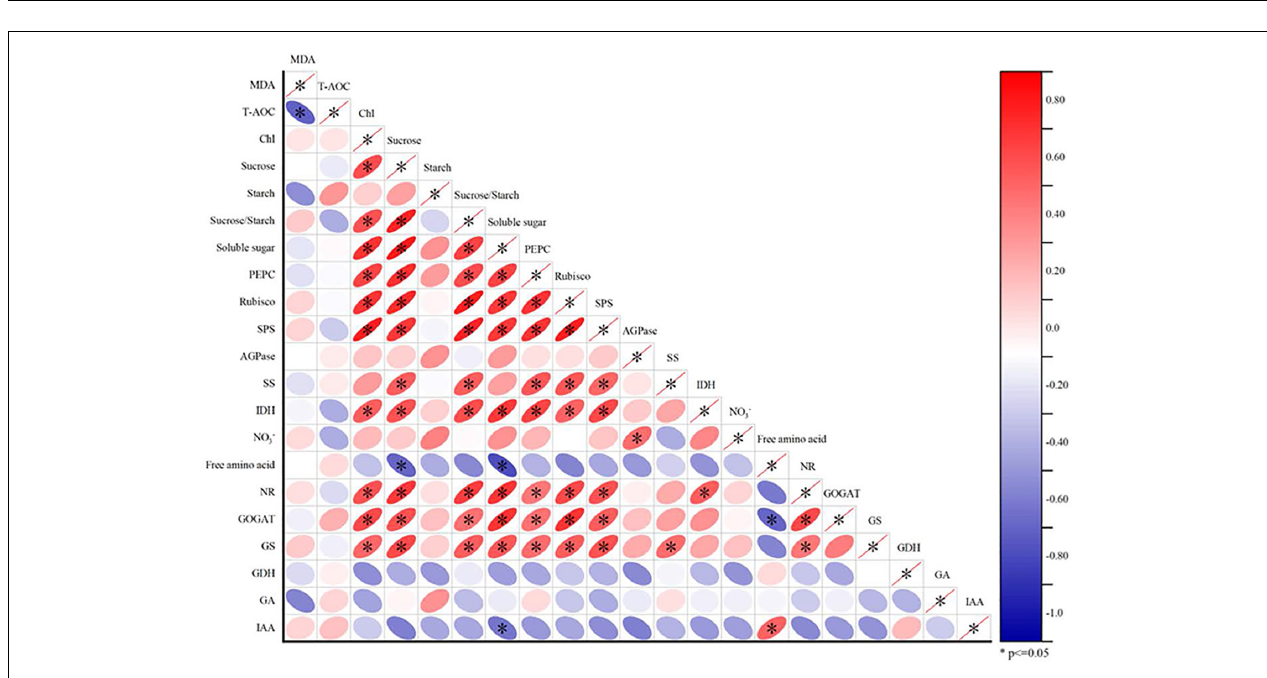
FIGURE 4 | Correlation analysis of maize leaf oxidative stress (MDA, T-AOC), carbon assimilation (Chl, sucrose, starch, sucrose/starch ratio, soluble sugar, PEPC, Rubisco, SPS, AGPase, and SS), organic acid metabolism (IDH), nitrogen metabolism (NO 3 − , free amino acid, NR, GOGAT, GS, and GDH) and endogenous hormones (IAA and GA). The color of the ellipse in each small square represents the degree of correlation between the two indicators, and the orientation of the ellipse indicates a correlation is positive or negative. ∗ P < 0.05 indicates statistically significant correlations.